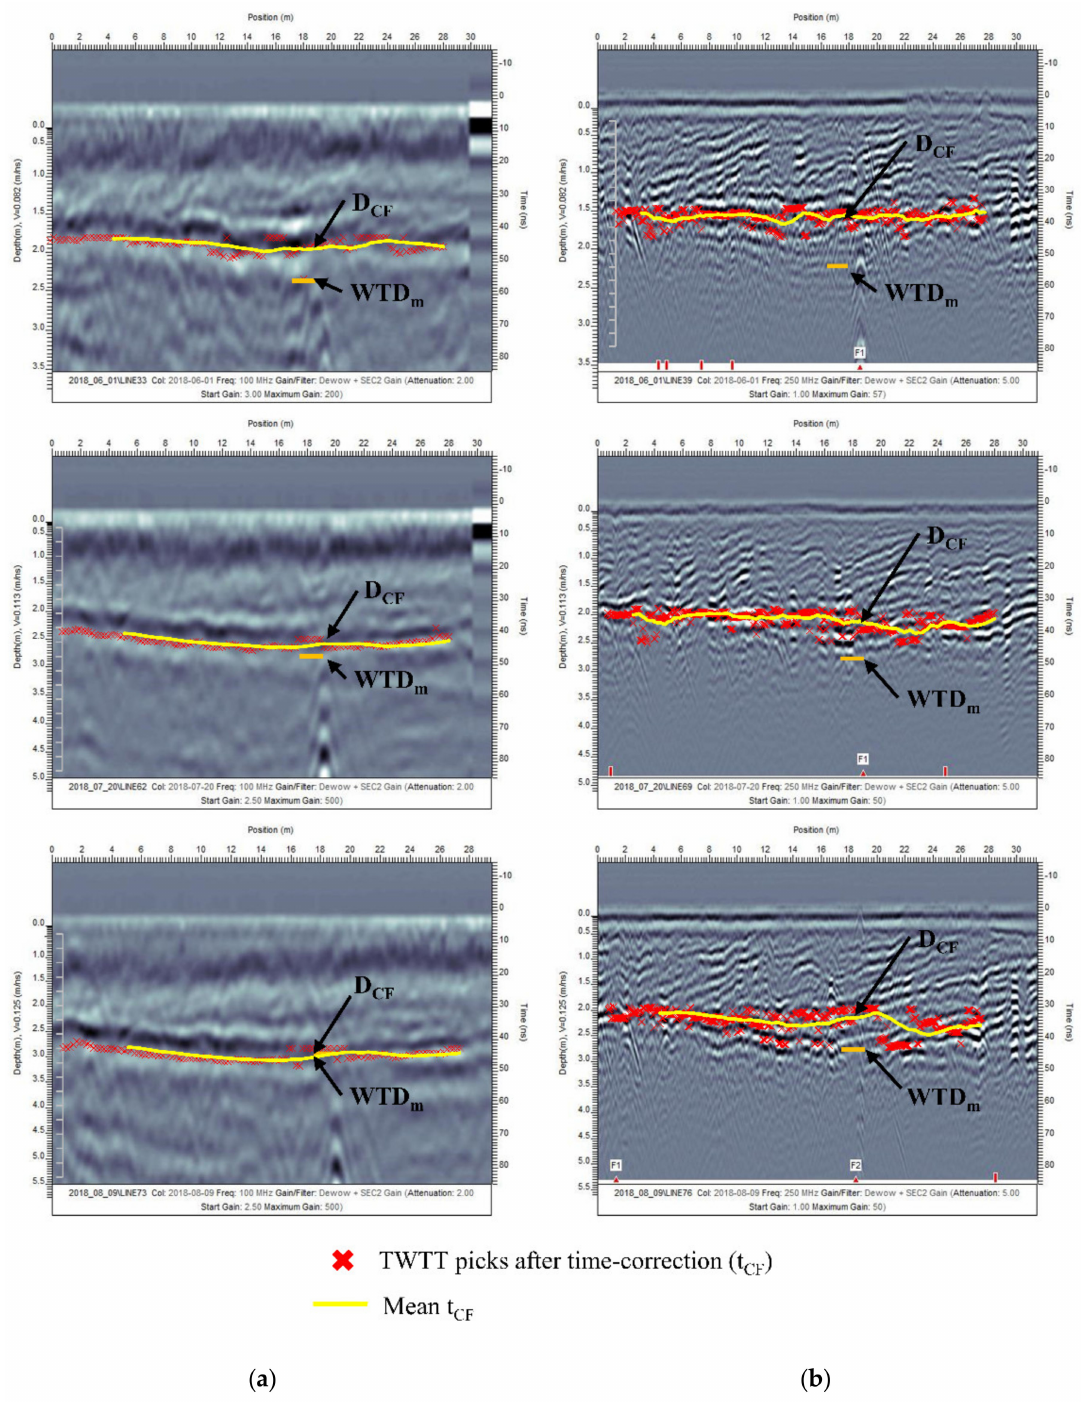
Figure 5. Comparison of ( a ) 100 MHz, and ( b ) 250 MHz ground penetrating radar (GPR) radargrams. Two-way travel time (TWTT) picks after time-correction, t CF , and the mean t CF are shown with measured water table depth (WTD m ) at the borehole (BH): ( above ) under wet soil moisture conditions on 1 June, ( middle ) under median soil moisture conditions on 20 July, and ( below ) under dry soil moisture conditions on 9 August in the growing season of